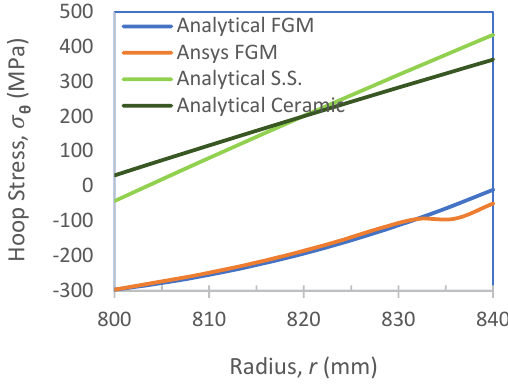
Figure 8. The variation of hoop stress with cylinder radius.